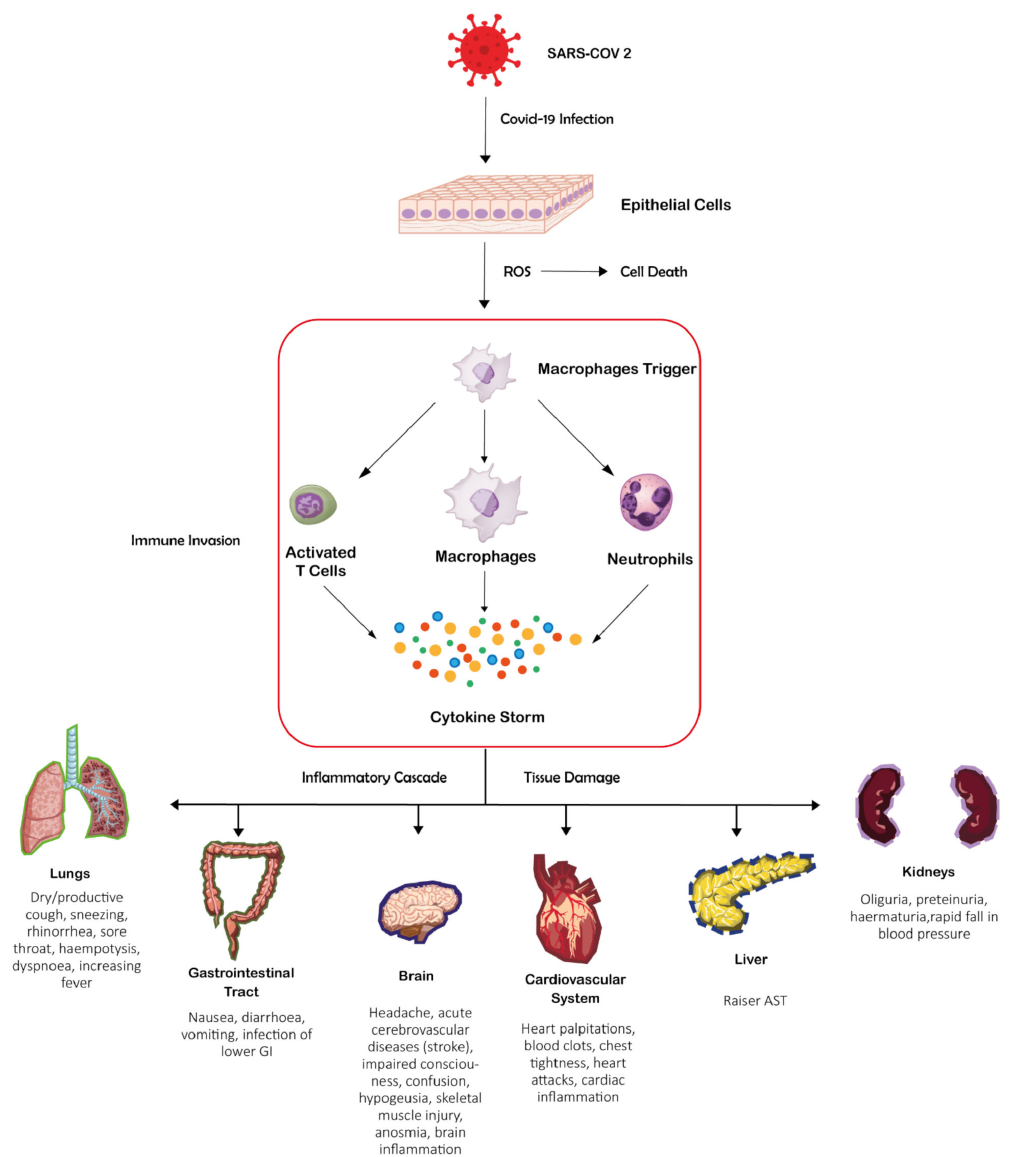
Figure 1. SARS-CoV-2 infection can induce a cytokine storm that prompts inflammation, local tissue harm, and systemic multi-organ